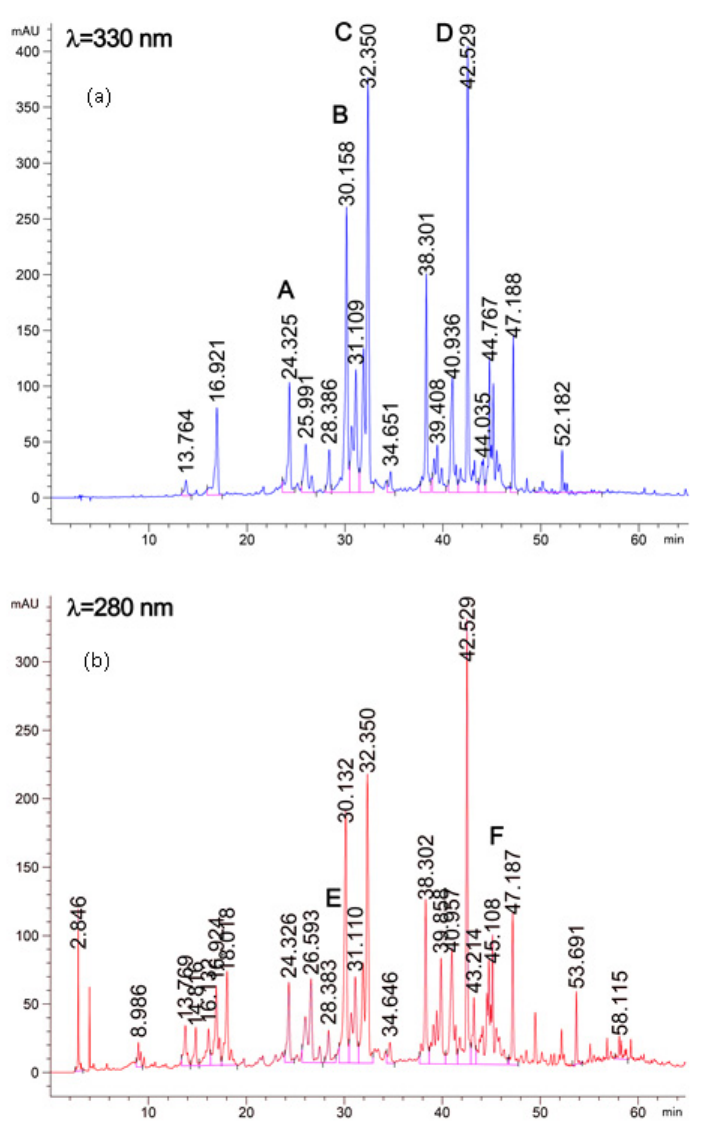
Figure 2. ( a ) Chromatogram and structure of the main identified compounds of thyme residues at λ = 330 nm: Luteolin-7-O-Neohesperidoside (A) Apigenin-7-Glucoronide (B), Rosmarinic acid (C), and Quercetin (D). ( b ) Chromatogram and structure of the main identified compounds of thyme residue extracts at λ = 280nm: Diosmin (E), and Olivetol (F).